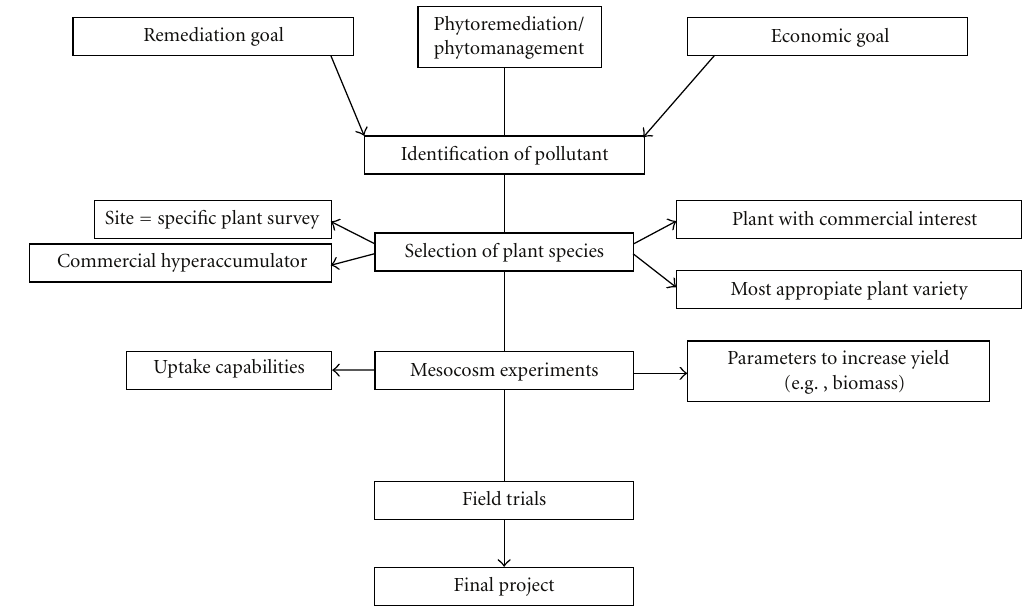
Figure 4: Phytoremediation decision